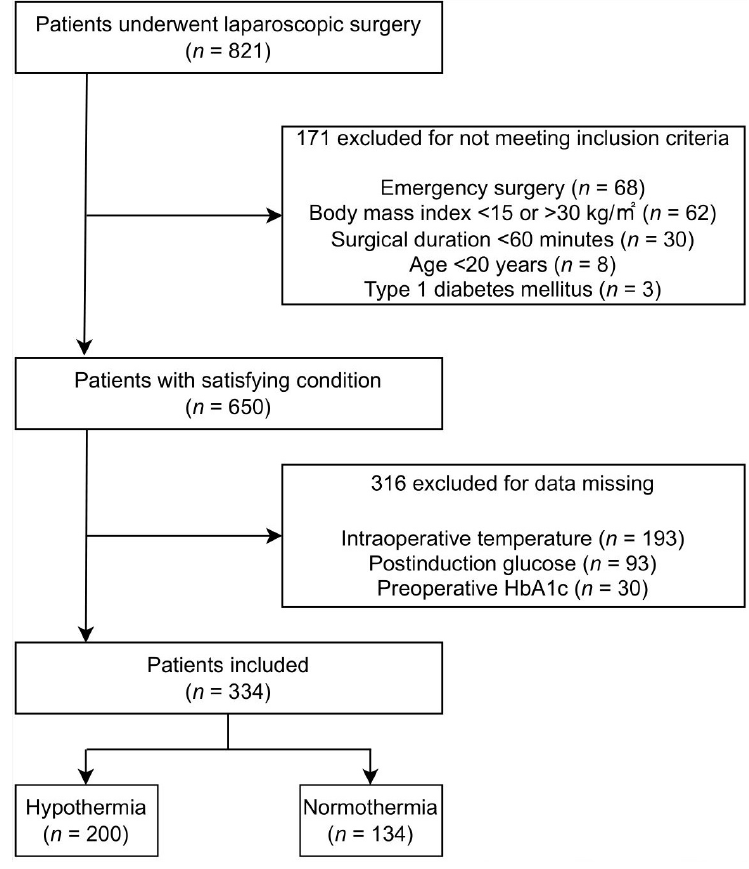
Figure 1. Study consort flow diagram. Table 1. Patient characteristics for hypothermic and normothermic patients.